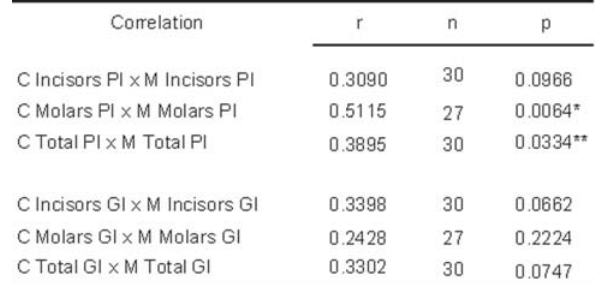
TABLE 3- Pearson’s correlation between the pairs of children (C) and mothers (M) when variables of plaque and gingival indexes for total, molars and incisors teeth are considered